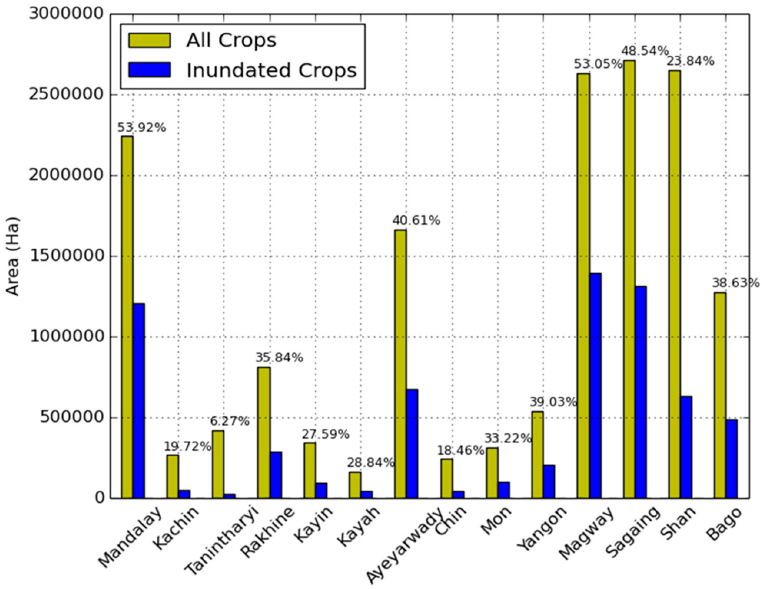
Figure 12. Inundation patterns in the Irrawaddy Delta region of Myanmar using dense time series Sentinel-1.